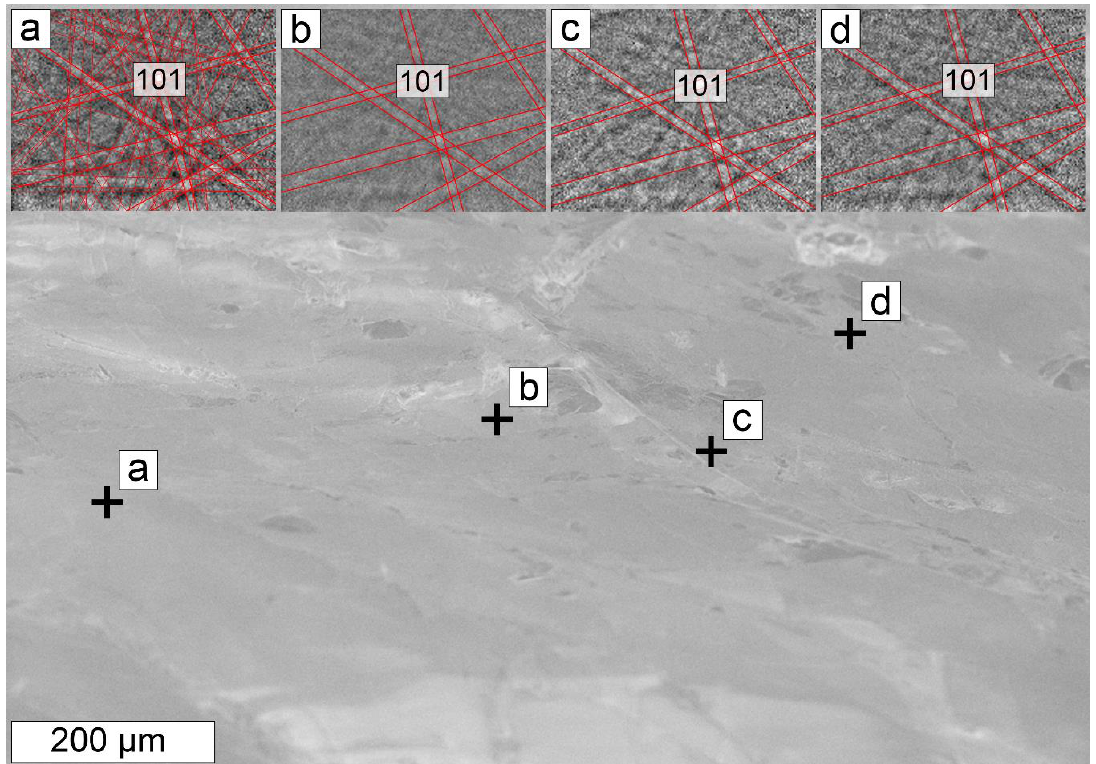
Figure 10. Secondary electron image of the growth surface of apatite which formed wholly in contact with betafite. Spots a – d and associated Kikuchi patterns represent EBSD analyses performed at each spot. ( a ) Pattern with labeled orientation solution for inset-point pairs ( a – d ). Red lines trace the indexed Kikuchi pattern for fluorapatite from the PDF-2 database (PDF 15-0876), with several of the strongest observed bands in bold and drawn for reference in ( a – d ). No well-defined bands were observed that did not match the indexed fluorapatite pattern. Numerous other spots across this surface produced the same diffraction pattern and orientation. Apatite surface was imaged using a 15.0 KeV accelerating voltage, 10.0 mm working distance, and a 120 µm aperture in variable pressure mode at a chamber pressure of 25 Pa.